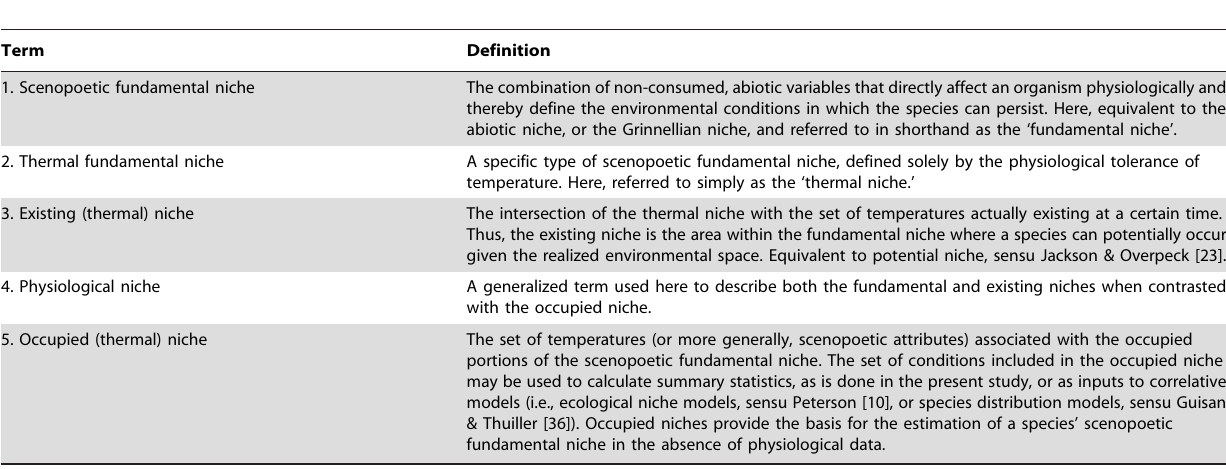
Table 1. Glossary of niche terminology, adapted from Peterson et al. [4], with reference to the present study; the terms collectively describe three niche classifications that are ordered hierarchically based on their size: fundamental $ existing $